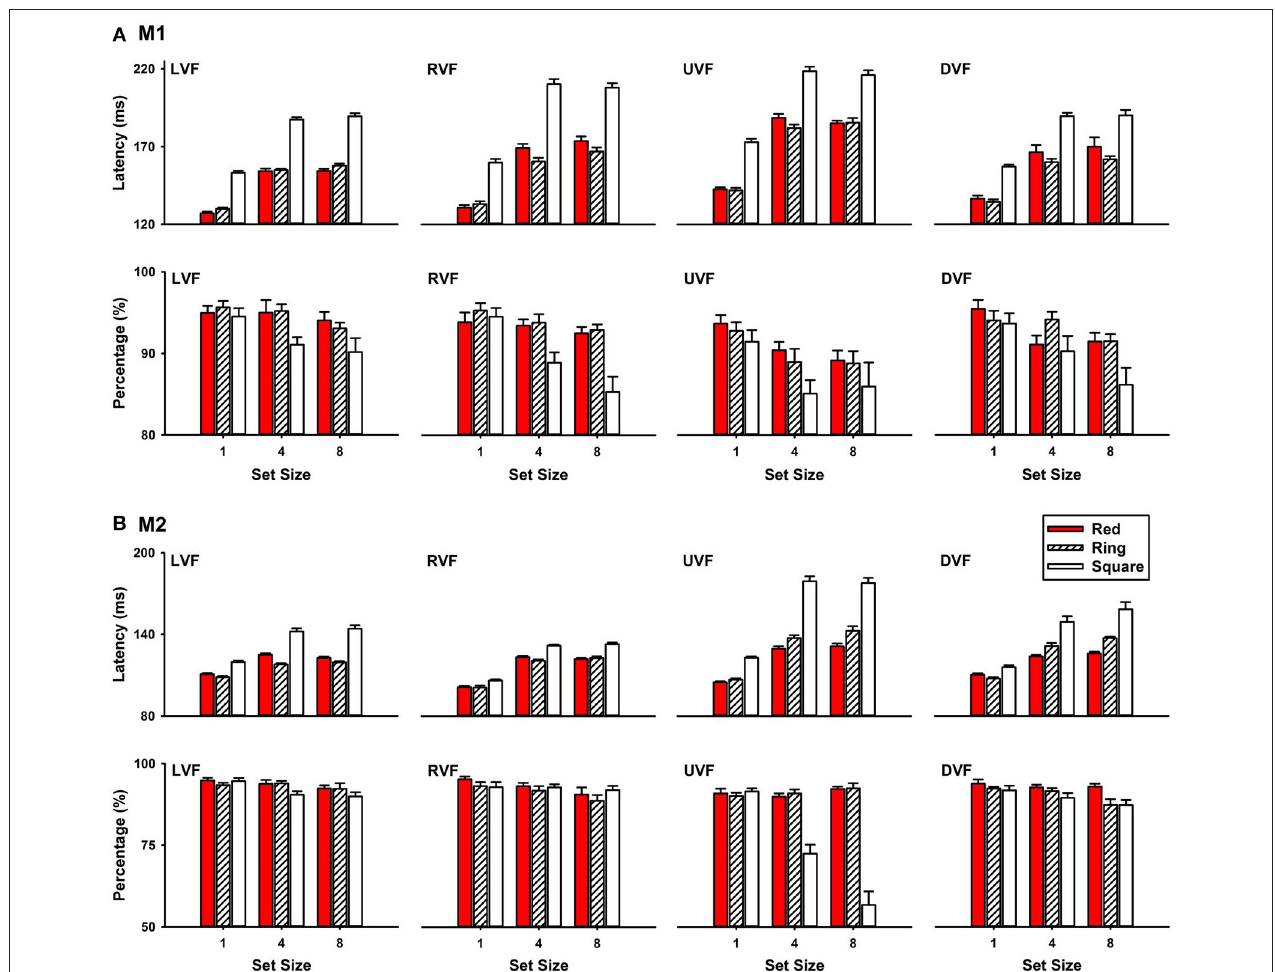
FIGURE 3 | Saccade latencies to targets at eccentricity 4 ◦ in the left, right, upper and down visual fields (LVF, RVF, UVF, and DVF) (A) , M1; (B) , M2. All percentages of correct trials were large than 80%.